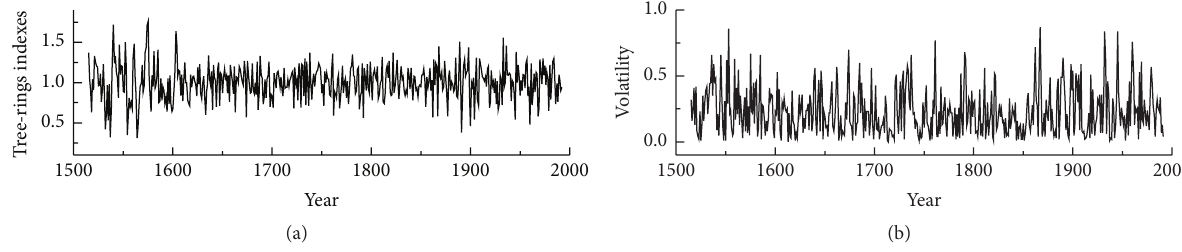
Figure1: Tree-ringtimeseries,(a)tree-ringwidth chronology forthepinesonthesouthernpeak oftheHuashan Mountains,and(b)tree-ring incremental